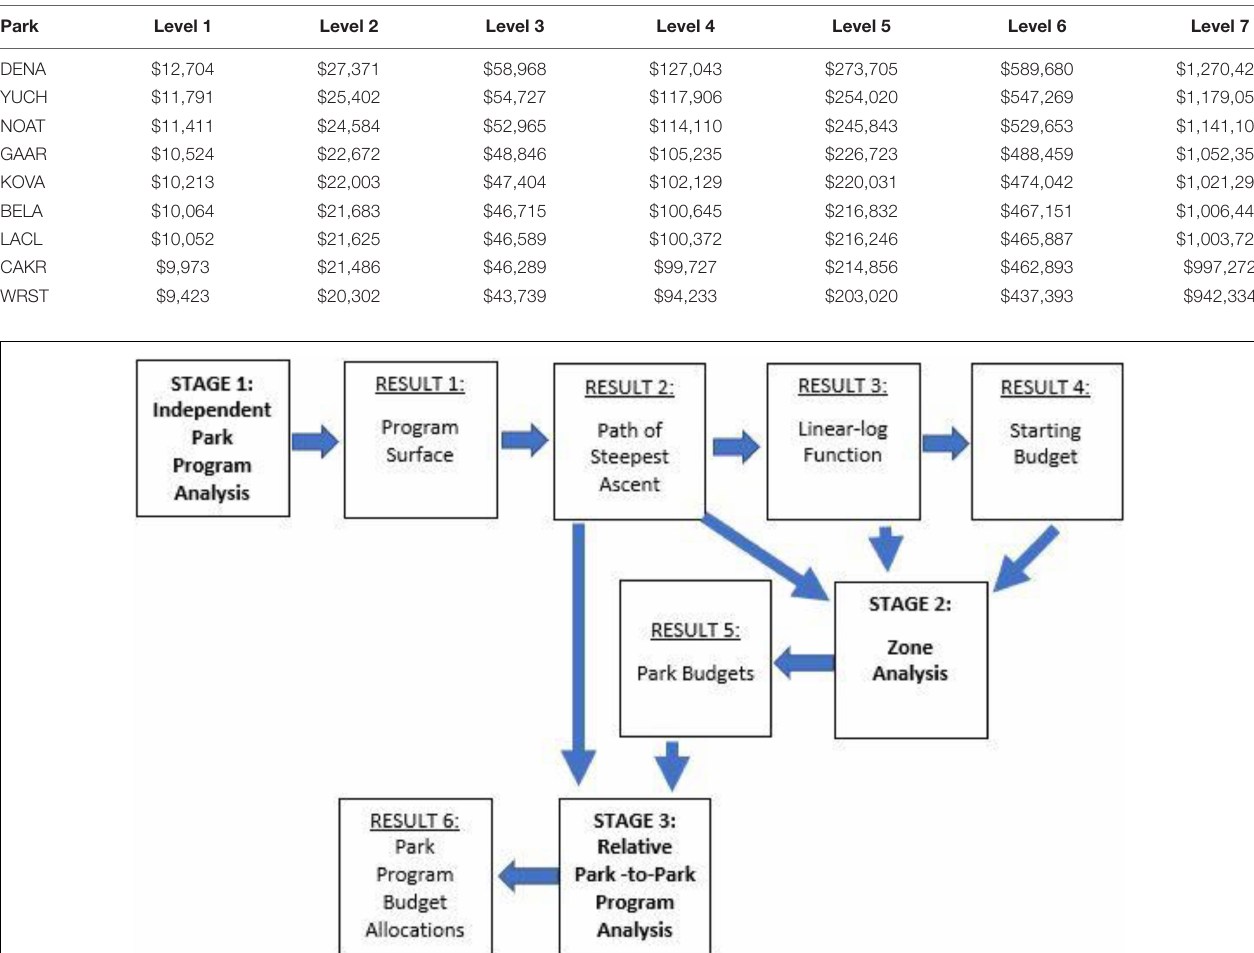
TABLE 2 | Preparedness budget by level for each park.